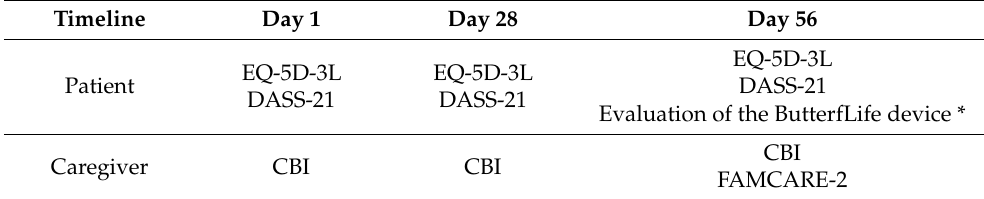
Table 2. Questionnaires during the eight weeks of monitoring time. Supplementary Document 2 includes all the questionnaires administrated to patients and caregivers by the physician on Day 1, Day 28 and Day